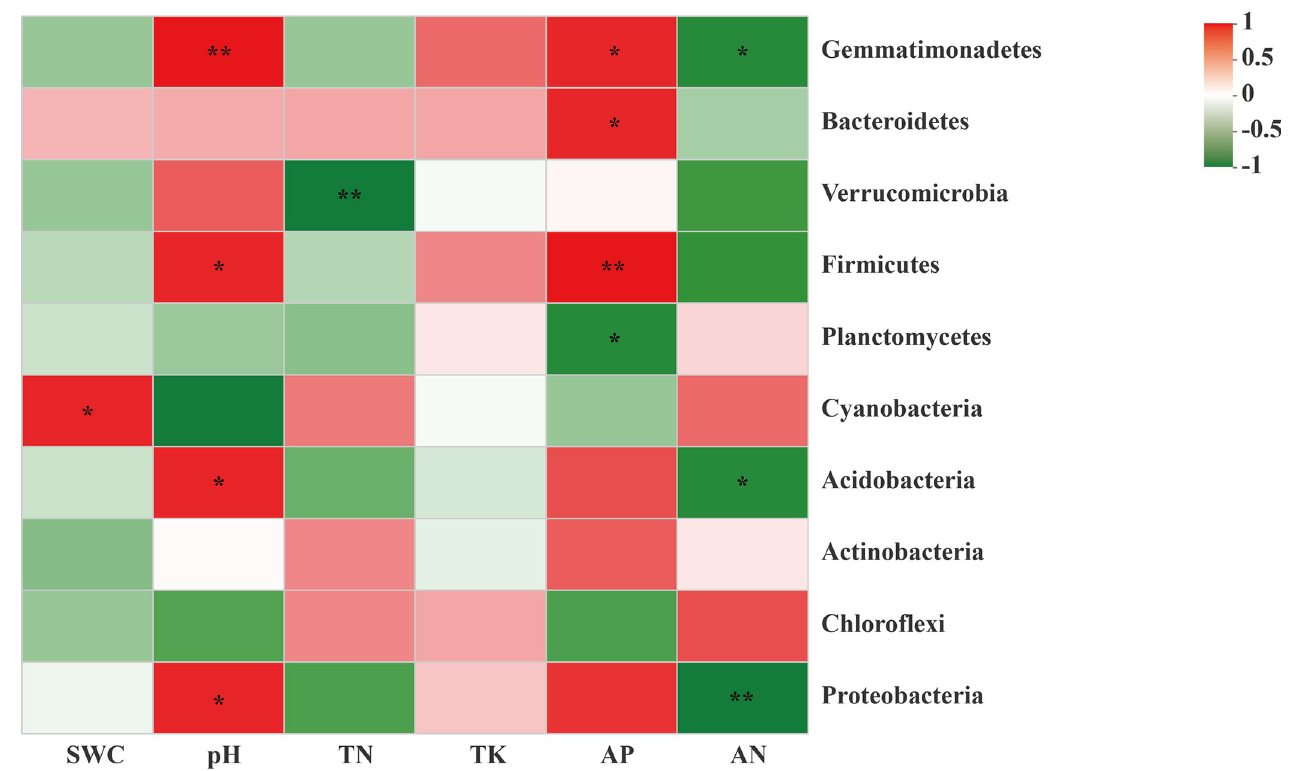
Fig 2. A correlation heatmap analysis between edaphic physicochemical factors and bacterial population at phylum level between moss- (M) and non- moss growth (L) areas in litchi orchard. Note : R values are shown in the figure in different shades of color, and they are marked with � , �� , or ��� , indicating p values less than 0.05, 0.01, and 0.001, respectively. SWC, soil water content; TN, total nitrogen; TK, total potassium; AN, available nitrogen; AP, available